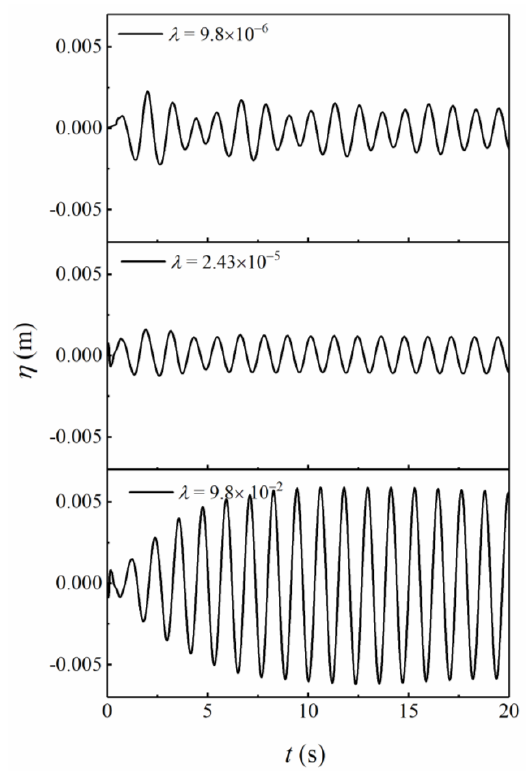
Figure 17. The time series of free surface elevation at y = 0 of sloshing under different baffle permeability coefficients (the unit of λ is m/s).